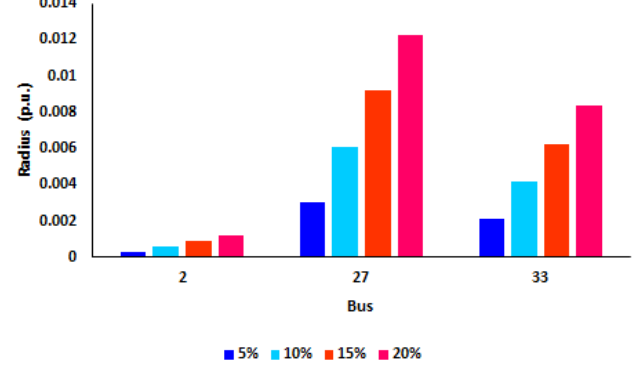
Figure 4. Radius of the Voltage Magnitude.